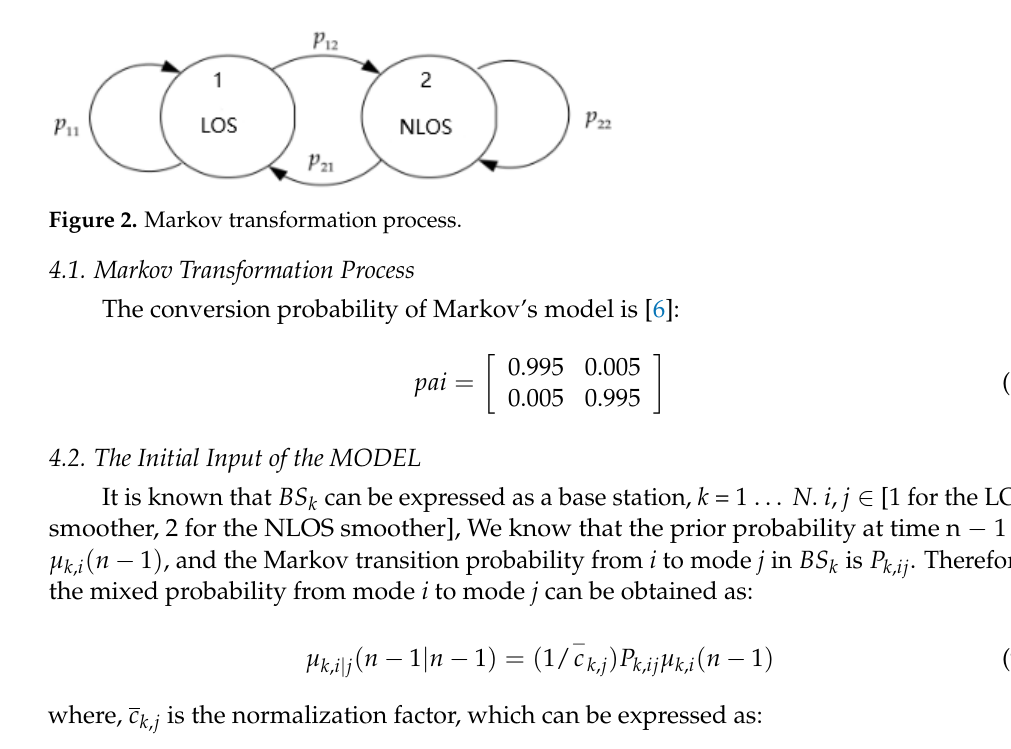
Figure 1. The flow chart of the proposed algorithm.